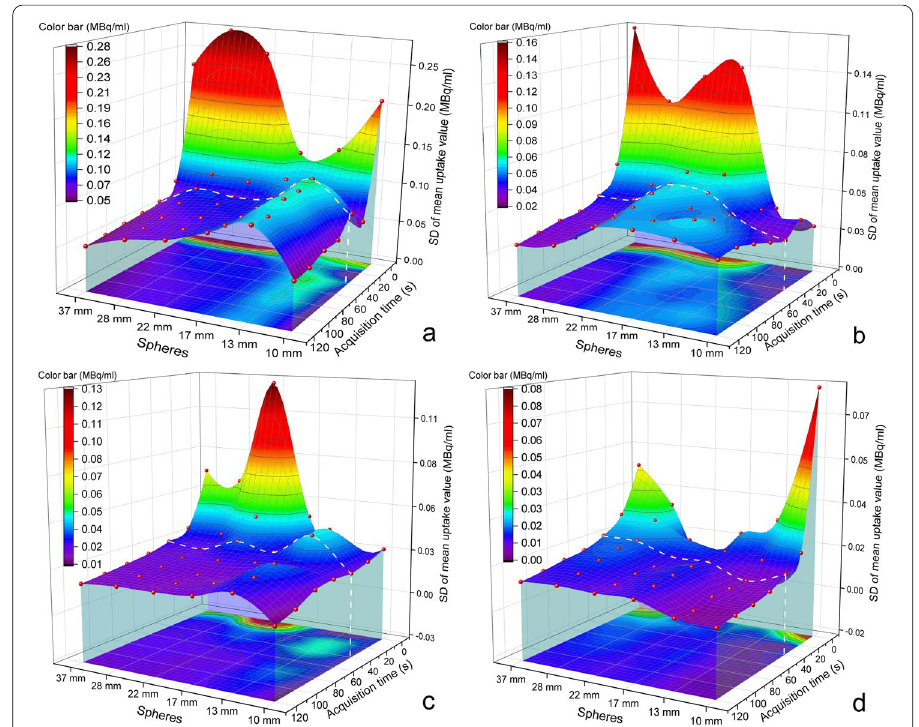
Fig. 8 Fitted 3D-scatter plot of standard deviations (SDs) of RCs. a 32:1 T/B ratio; b 16:1 T/B ratio; c 8:1 T/B ratio; d 4:1 T/B ratio; X-axis indicates 6 spheres (37 mm, 28 mm, 22 mm, 17 mm, 13 mm, and 10 mm); Y-axis indicates SD of RCs; Z-axis indicates different acquisition time/frame (1–120 s/frame); White dashed line is the proposed cut-off value for acquisition time (40 s/frame). Fixed reconstruction parameters: 35 iterations, 20 subsets, no filter, AC SC RR combination; Fixed acquisition parameters: 15% energy + +